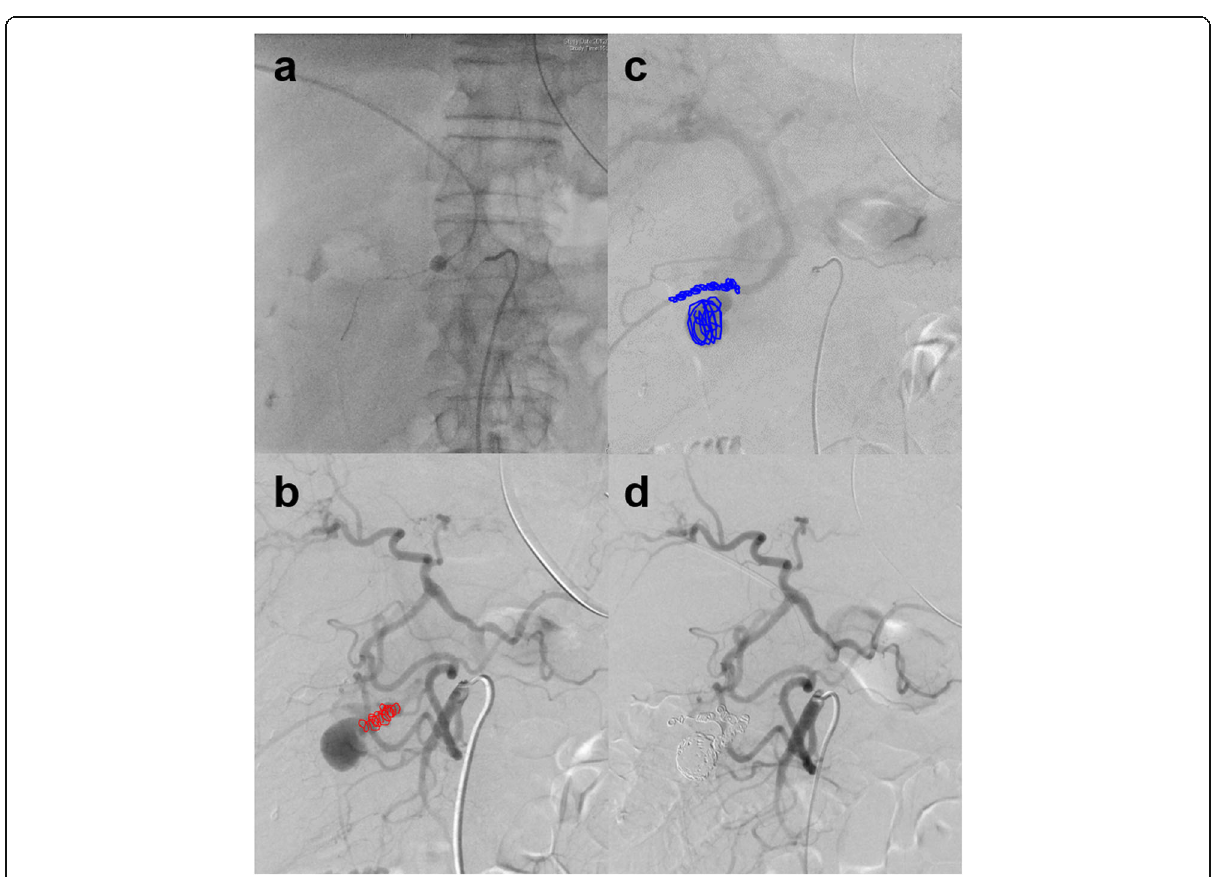
Fig. 3 Emergency angiography and interventional radiology. a The catheters were advanced via the artery and the portal vein. b Left-anterior oblique 20-degree image of the arterial phase of superior mesenteric arteriography. The embolic microcoils placed from the arterial catheter to the inflow branch of the pseudoaneurysm are shown in red. c An image of the portal phase following Fig. 3b. The embolic microcoils placed in the pseudoaneurysm and outflow vessel from the transportal catheter are shown in blue. d Superior mesenteric arteriography demonstrating the disappearance of blood flow to the pseudoaneurysm after coil embolization using a combination of the arterial and percutaneous transhepatic portal venous